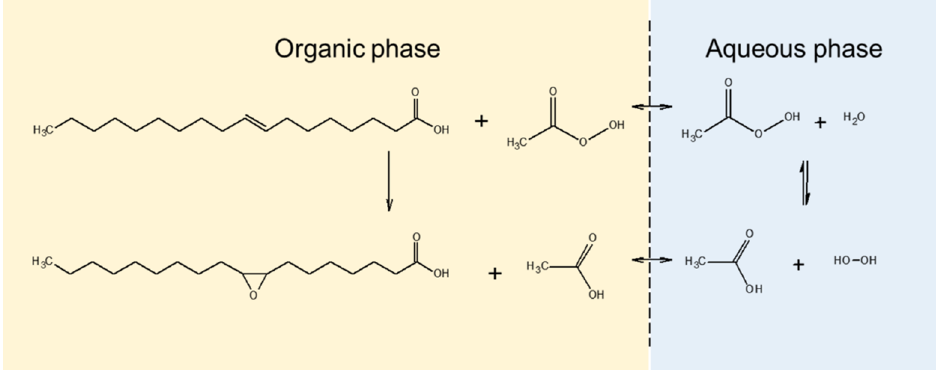
Figure 5. Epoxidation of oleic acid by the Prilezhaev method, using acetic acid. Table 3 categorizes the different catalytic epoxidation systems and their perfor- mances using a wide range of oil types. Table 3. Overview of different types of oils, the catalytic system and their yields reported in the literature.